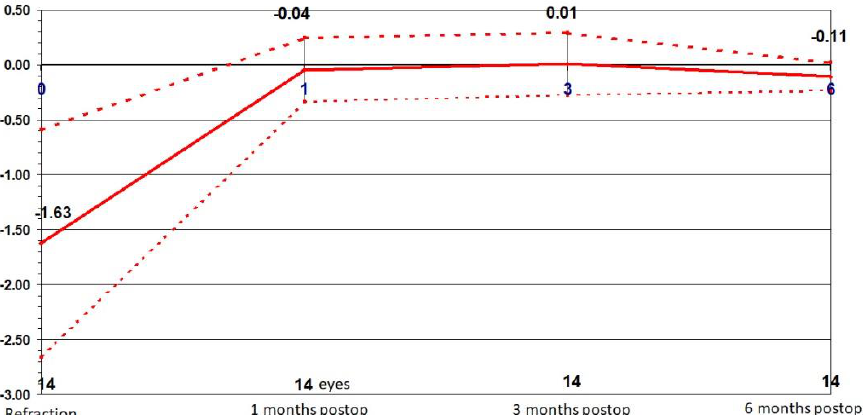
Figure 3. Stability: Change in refraction over time in the dominant eye.